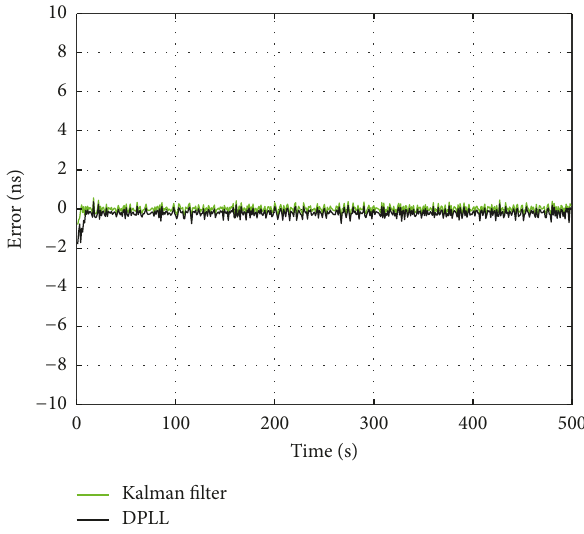
Figure 6: The difference between estimated time and real time.